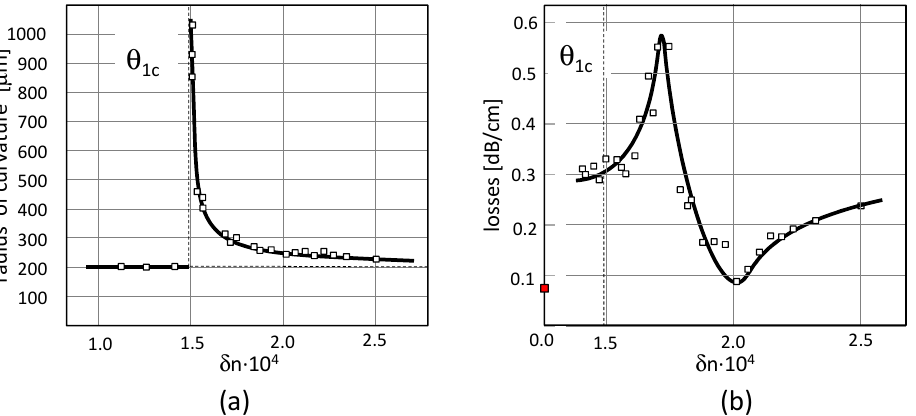
Figure 8. Radius of curvature and propagation losses calculated from numerical experiments: ( a ) Radius of curvature as a function of the refractive index contrast; ( b ) Propagation losses as a function of the refractive index contrast.